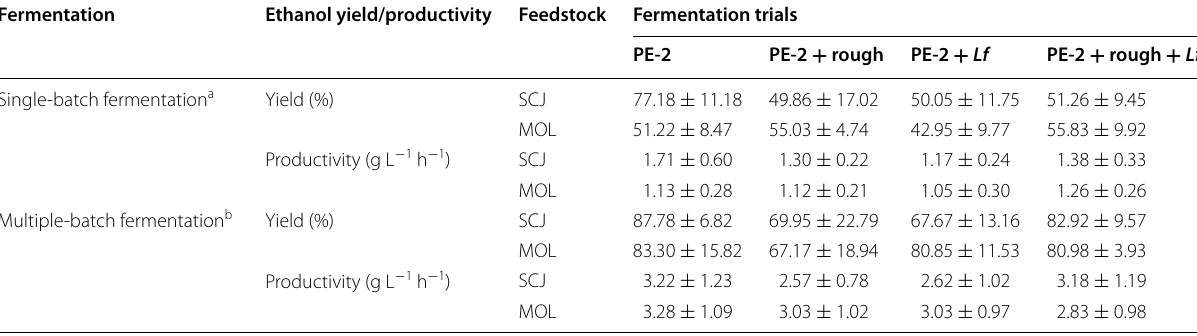
Results are the mean standard deviation of eight a or twelve b ±